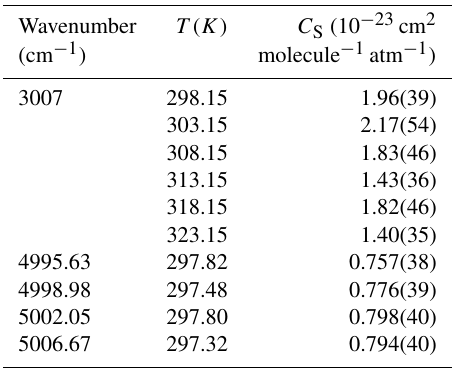
Table 1. Self-continuum absorption cross-sections of water vapour measured near 3007 and 5000cm − 1 .